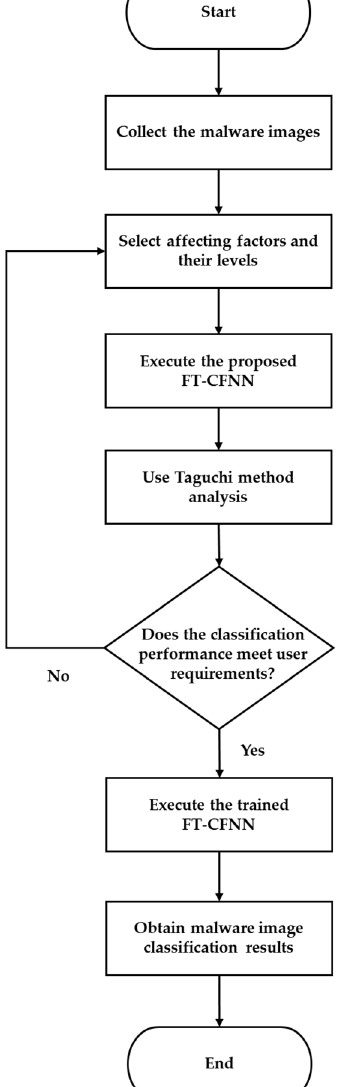
Figure 1. Flowchart of malware image classification with the FT-CFNN.